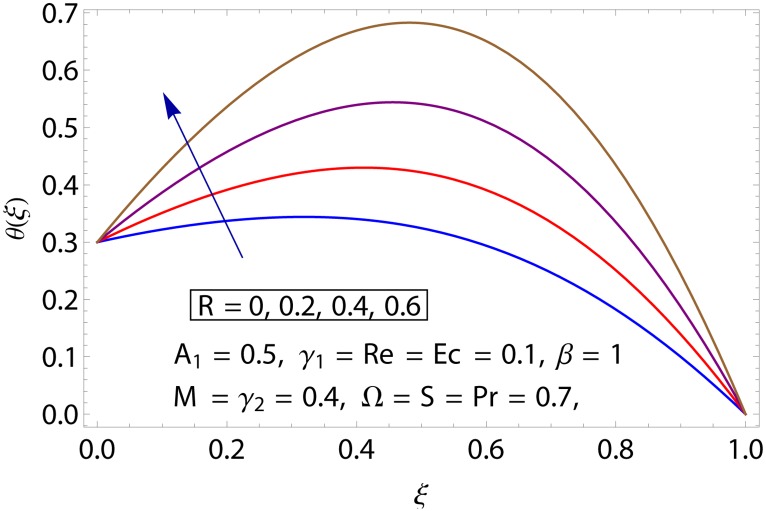
Impact of R on θ(ξ).